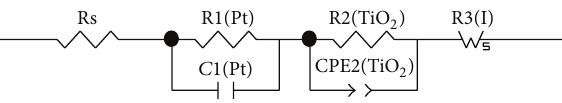
Figure 7: Equivalent circuit of DSC.